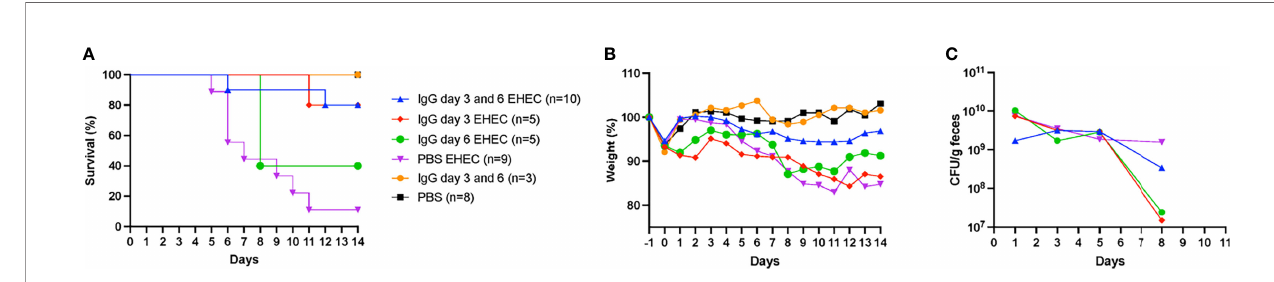
FIGURE 1 | Murine IgG given on day 3 or day 3 and 6 protected mice from E. coli O157:H7-induced disease. (A) Survival in mice infected with E. coli O157:H7 (EHEC) and treated with IgG on day 3 and 6 (n=10, blue line), day 3 (n=5, red line), day 6 (n=5, green line), untreated (n=9, purple line) and uninfected controls treated with IgG (n=3, yellow line) and without IgG (n=8, black line). (B) Weight changes in infected and uninfected mice, starting 1 day before inoculation, at the start of fasting, until day 14 post-inoculation, when the experiment ended. (C) Bacterial colony forming units in feces of EHEC infected mice on days 1, 3, 5 and 8. Results are presented